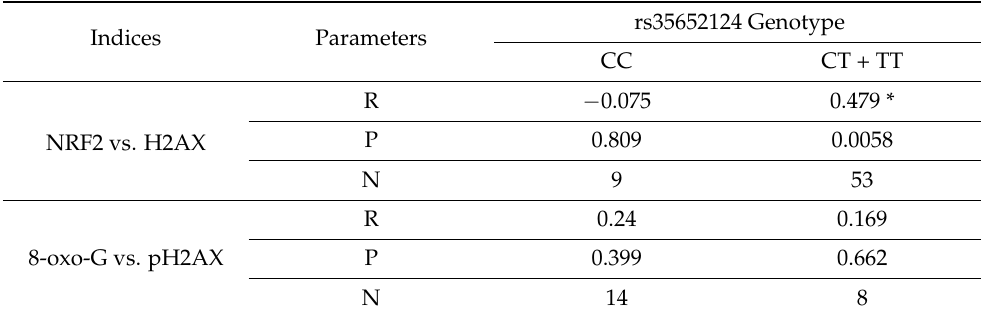
Table 4. Spearman correlation of genotoxic and adaptive responses cells from different NRF2 rs35652124